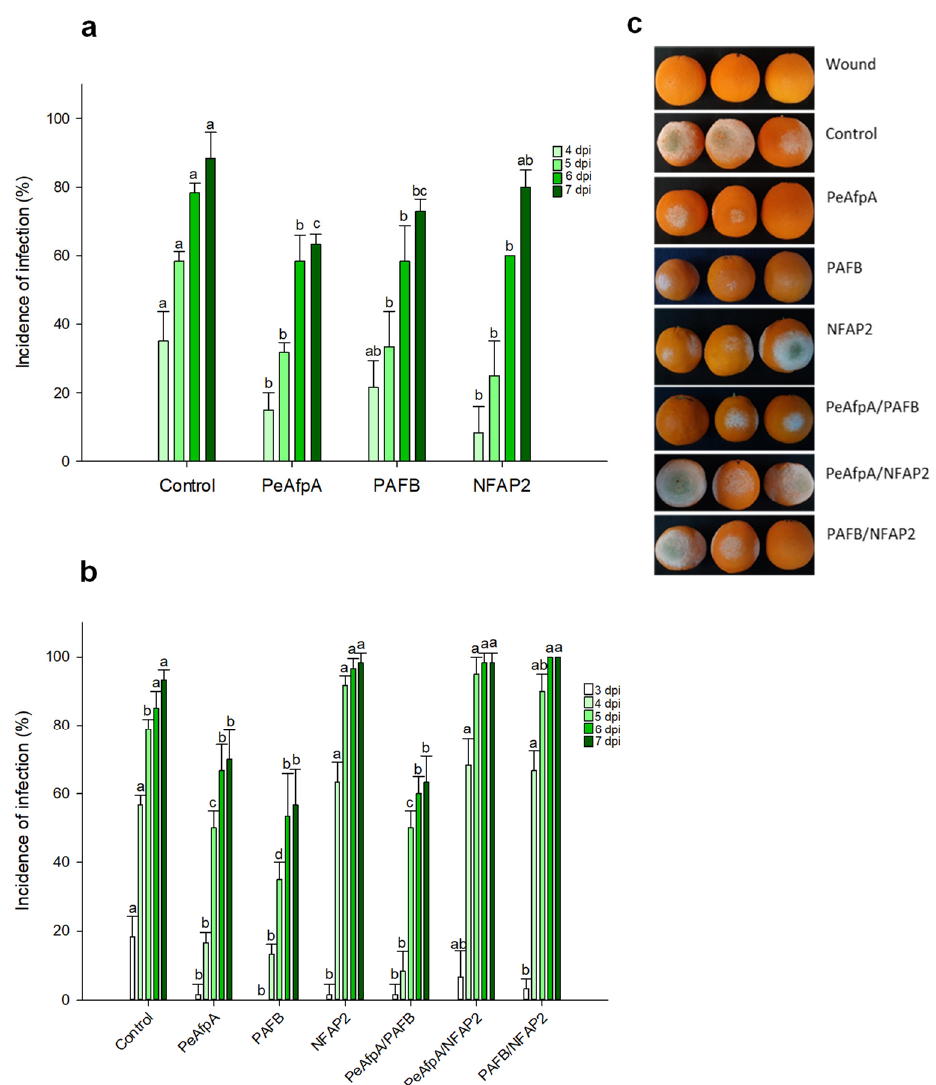
Figure 2. Effect of different antifungal proteins on the infection of orange fruits cv Navel by P. digitatum . ( a ) Effect of PeAfpA, PAFB and NFAP2 on the infection of orange fruits. ( b ) Effect of PeAfpA, PAFB, NFAP2 and combinations on the infection of orange fruits. Orange fruits were inoculated with 10 4 conidia/mL of P. digitatum either alone (Control) or in the presence of 100 µg/mL of AFPs (corresponding to 15 µM PeAfpA, 16 µM PAFB and 18 µM NFAP2). Bars show the mean values of the percentage of infected wounds and standard deviation (SD) of three replicates of five oranges at 3, 4, 5, 6, and 7 dpi. Letters show significant differences among the treatments at each independent day (one-way ANOVA and Tukey’s HSD test, p < 0.05). ( c ) Representative images of treated oranges of ( b ) with AFPs and combinations at 7 dpi.